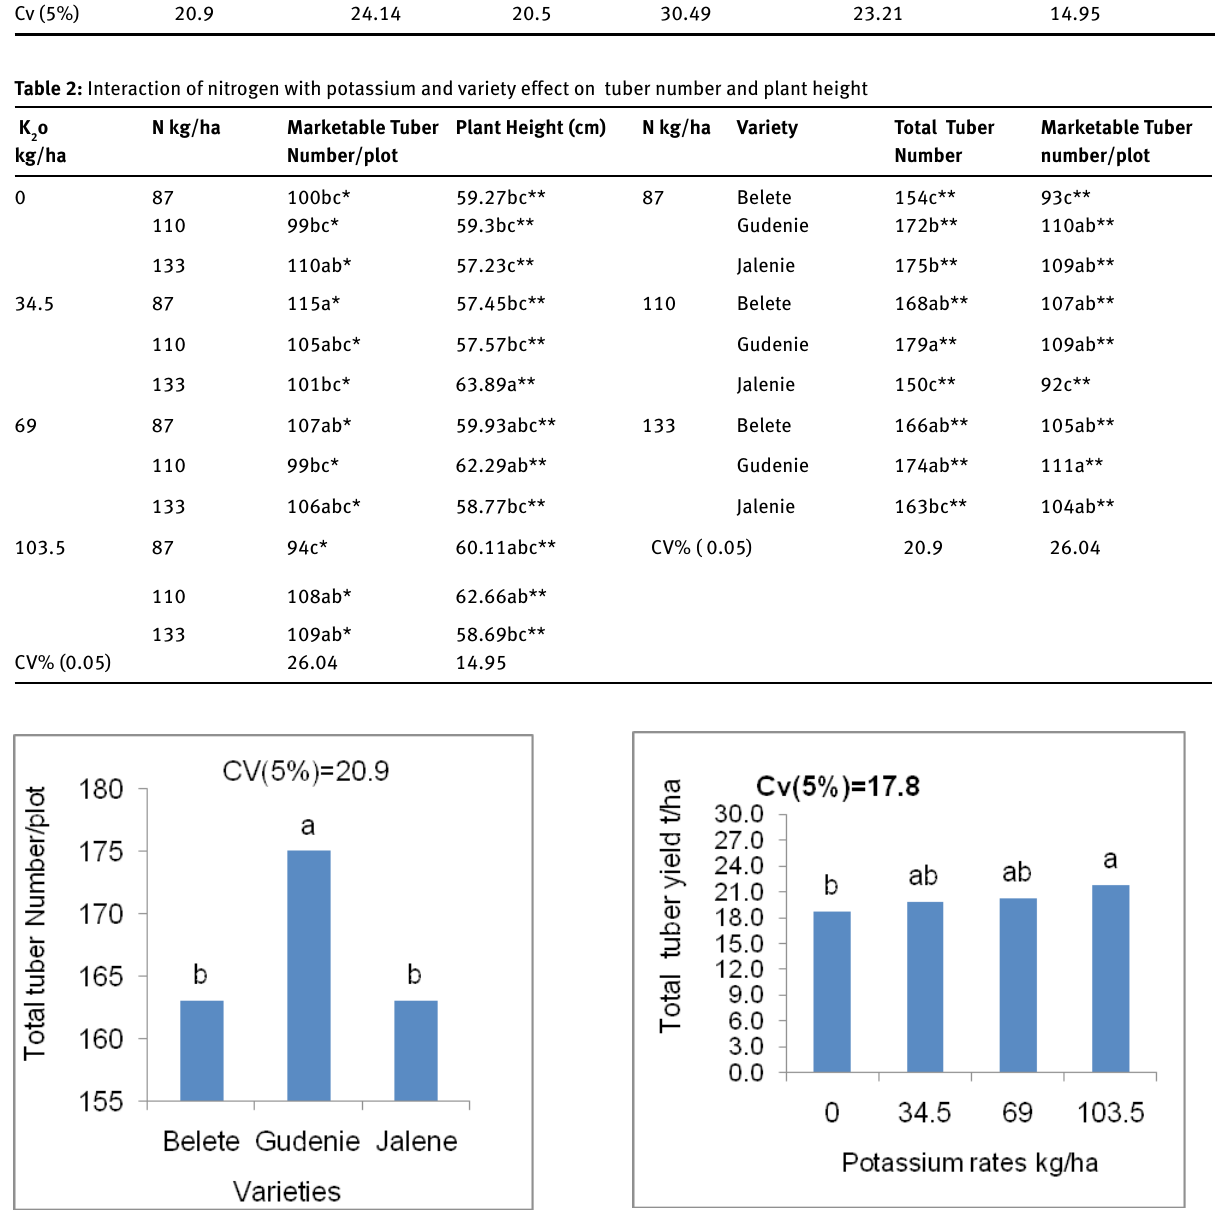
Figure 2: Total tuber weight results for 0, 34.5, 69 and 103.5kg/ ha potassium rates. The 1 st , 2 nd , 3 rd and 4 th columns indicated the 0, 34.5, 69 and 103.5kg/ha potassium rates results for total tuber weight ton/ha, respectively